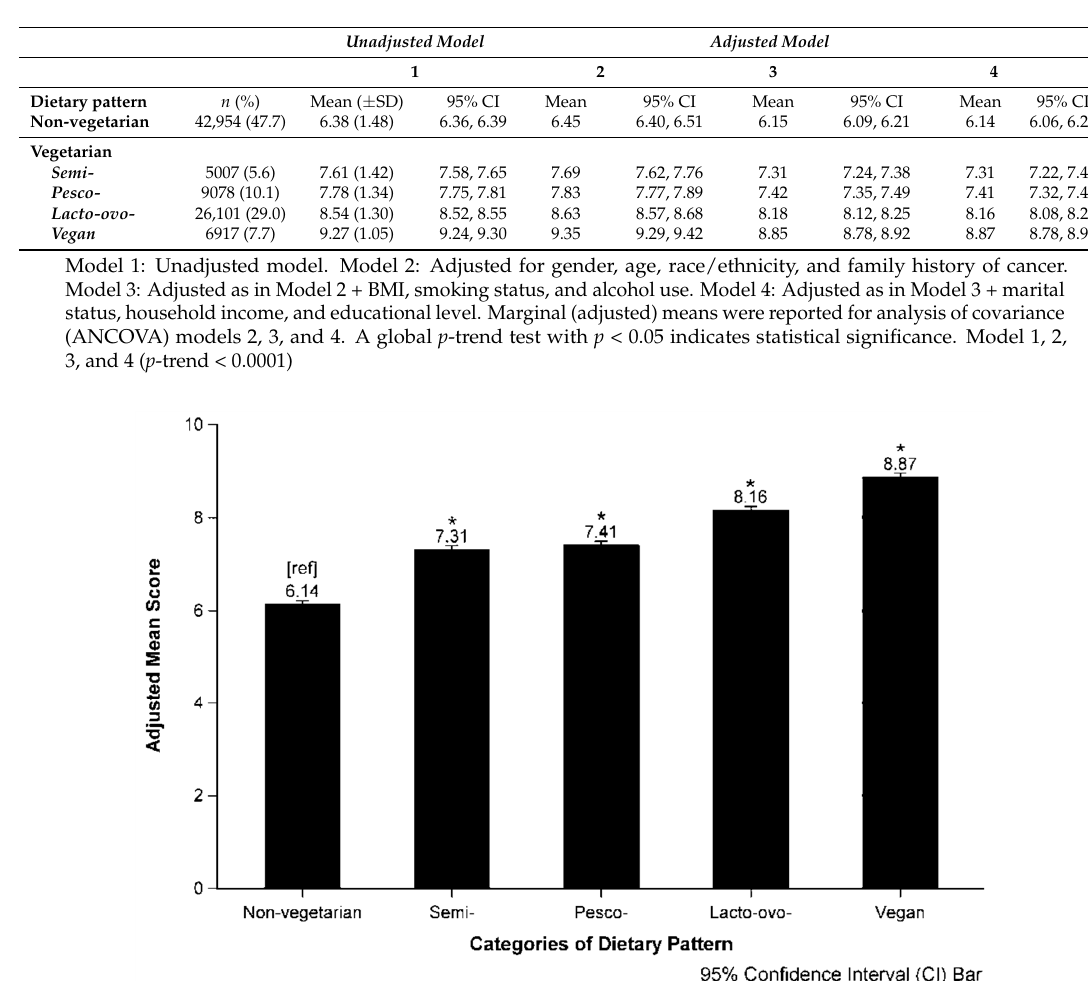
Figure 2. Vegetarian Lifestyle Index score according to categories of dietary pattern in the Adventist Health Study-2 (AHS-2) population. Adjusted for gender, race/ethnicity, family history of cancer, BMI, smoking status, alcohol use, marital status, household income, and educational level. * Significant difference between categories of dietary pattern with non-vegetarian as the reference [ref] group.